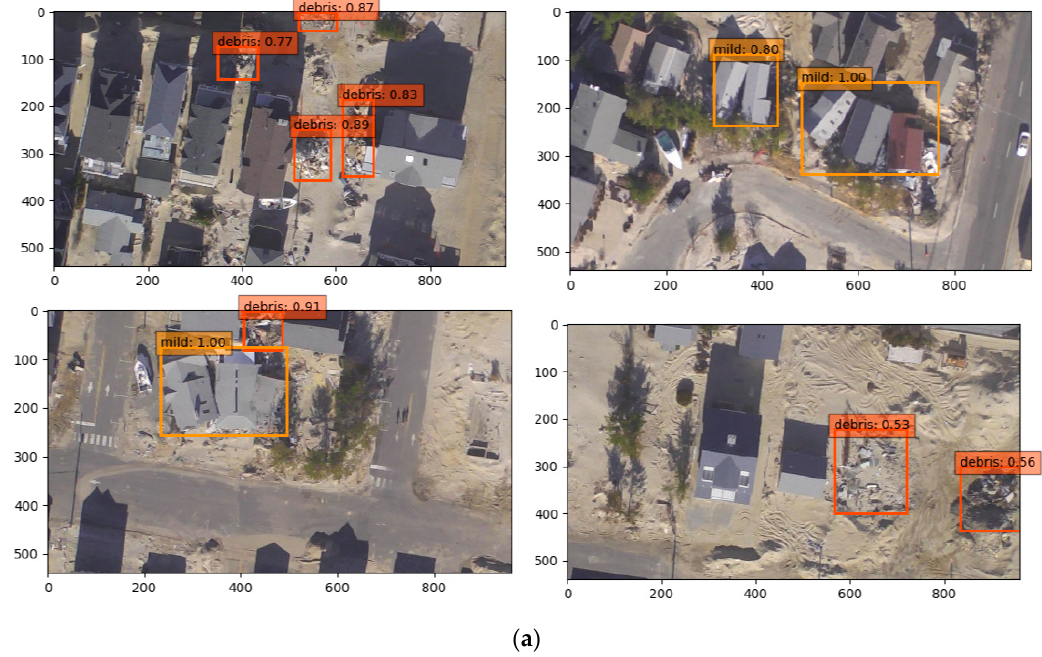
Table 6. Impact of data augmentation using the SSD_CAE